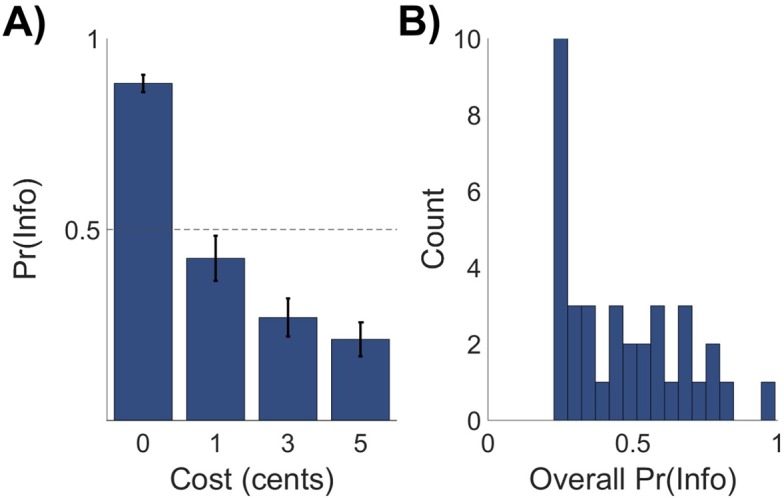
Behavioral results for Experiment 1.(A) Mean proportion of informative stimulus choices (denoted Pr(Info)) as a function of information cost. Error bars represent the standard error of the mean (SEM). Mean proportion of information-seeking choices was monotonically decreasing in cost of information. (B) Histogram of overall proportion of informative stimulus choices across participants, demonstrating inter-individual differences in behaviour. N = 40.